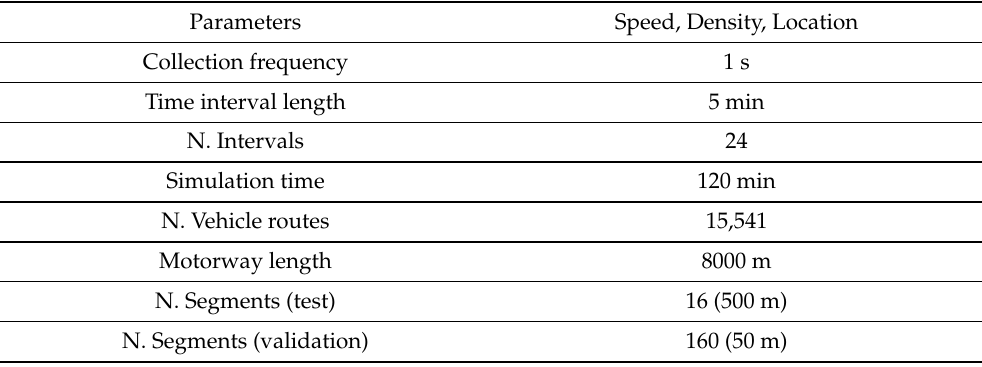
Table 2. Exported data from simulation scenarios.